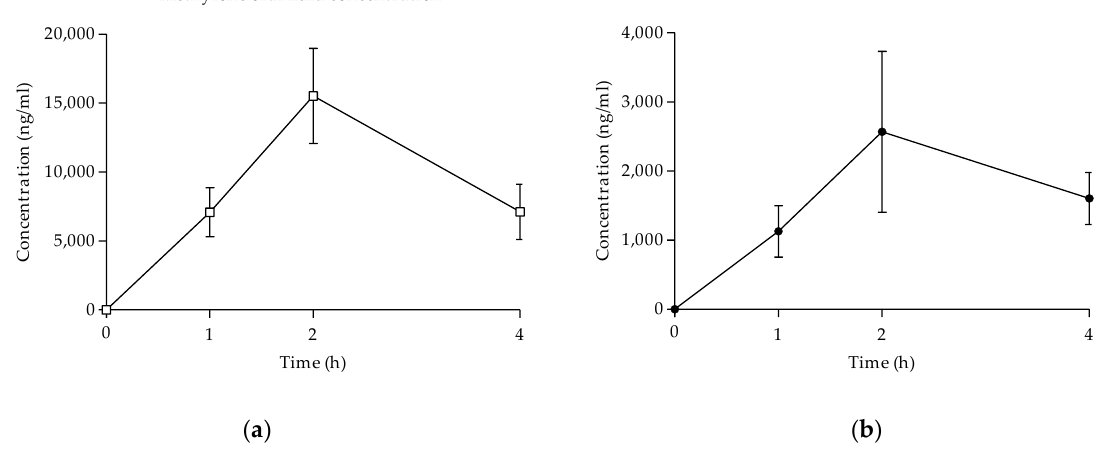
Figure 3. Evolution of concentrations of methylone ( a ) and MDMA ( b ) in oral fluid over time ( □, 10 0 – 300 mg methylone ( n = 8) ; ●, 7 5 – 100 mg MDMA ( n = 6); mean, standard